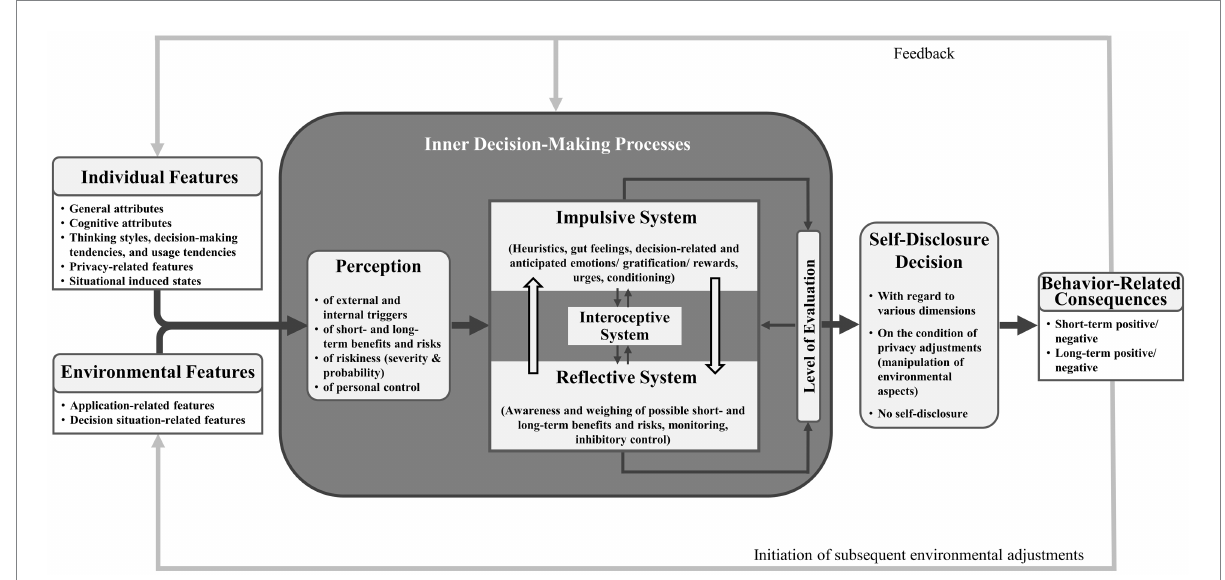
FIGURE 1 The Tripartite Self-Disclosure Decision (TSDD) model with bold arrows representing the main pathway of the self-disclosure decision-making process on social